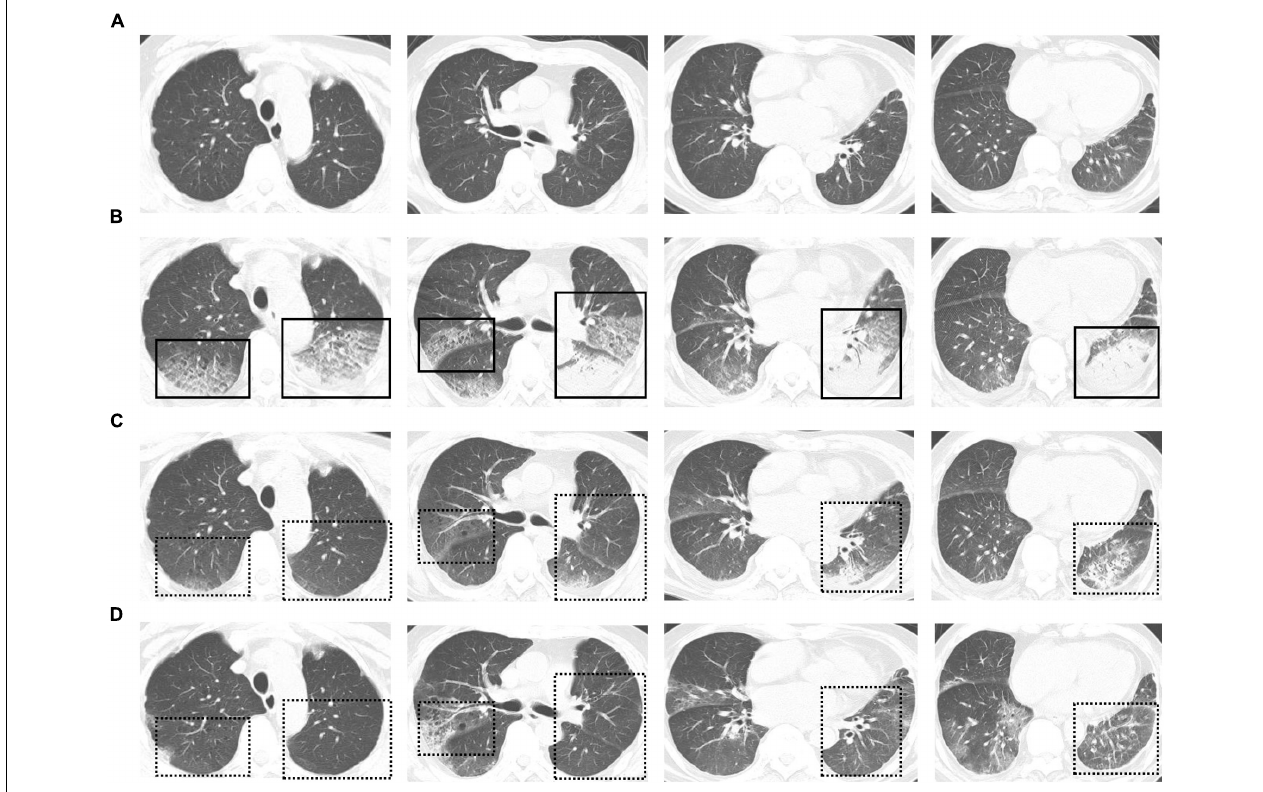
FIGURE 1 | (A) Chest computed tomography (CT) scans obtained on March 25th. Few pulmonary ground-glass opacities can be seen. (B) Chest CT scans obtained on March 27th. Exudative infiltrates and consolidation, mainly on the right upper lung, left upper lung, and left lower lung, can be seen. An air bronchial sign can be seen in the consolidation shadow. (C,D) Follow-up chest CT scans obtained on March 30th (C) and April 3rd (D) . Pulmonary lesions were restored after treatment. Solid boxes show the new pulmonary lesions on chest CT. Dotted line boxes show restored pulmonary lesions on follow-up chest